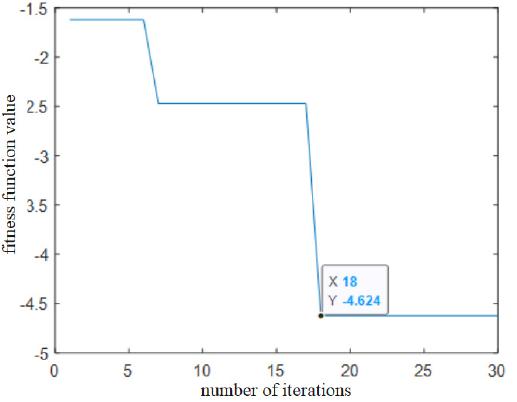
Figure 7. Fitness function curve of the simulated outer ring signal.